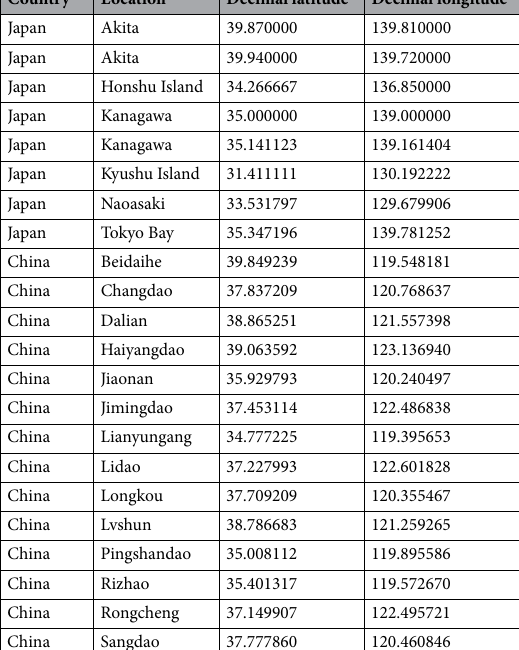
Table. 1. Distribution data of Apostichopus japonicus . The distribution data of A. japonicus in Japan was obtained from the Global Biodiversity Information Facility (GBIF, http:// www. gbif. org). The distribution data in China was obtained from literature 40